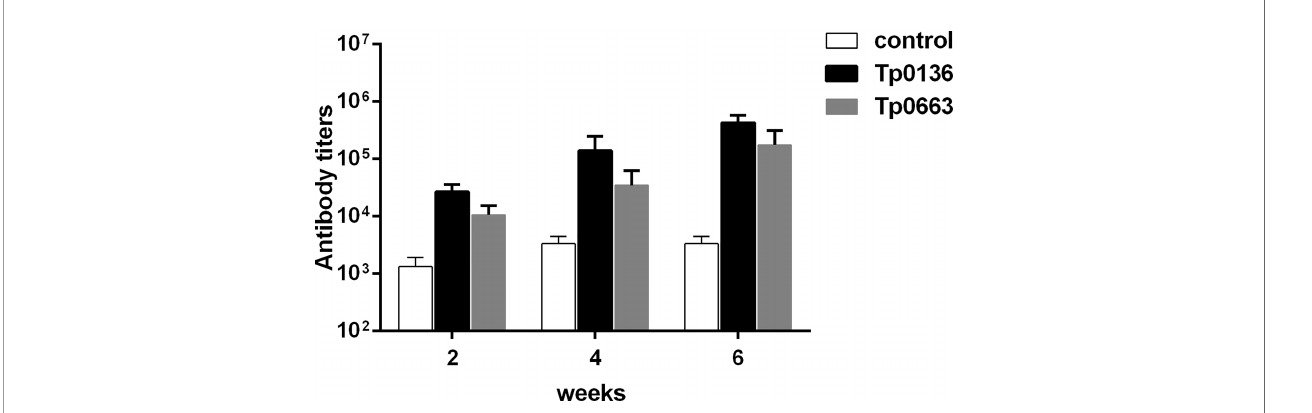
FIGURE 1 | Antibody titers in rabbits immunized with recombinant Tp0136 or Tp0663 protein. New Zealand rabbits were immunized with 150 m g of recombinant protein Tp0136 or Tp0663 emulsi fi ed in complete Freund ’ s adjuvant system. The control rabbits were immunized with PBS emulsi fi ed in complete Freund ’ s adjuvant system. Each animal was injected three times at two week intervals (0, 2, and 4 weeks). Blood was drawn from the rabbit ear veins at 2, 4, and 6 week, and the IgG antibody levels were determined by indirect ELISA. Each set of data is based on measurements derived from three rabbits. To determine antibody concentrations (titers), two-fold serial dilutions of serum were made and the endpoint titer was considered to be the last serum dilution with readings higher than the mean + 3SD of the negative